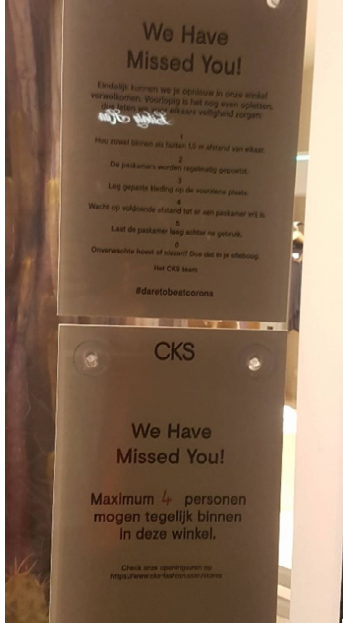
Figure 14. We have missed you!